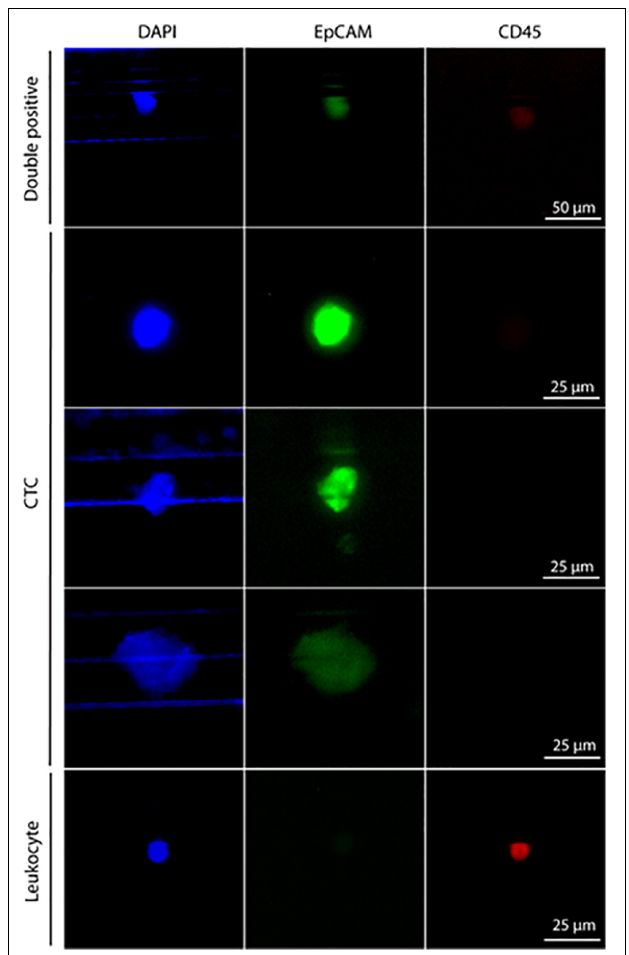
FIGURE 2 | Staining of cells isolated with Parsortix from patient #95. Cells were forced to pass through a 6.5- µ m cassette in the Parsortix system and then stained with different antibodies. Nuclei stained with DAPI (blue), CD45 (red), and EpCAM (green). From top to bottom: double-positive cells (CD45 + , EpCAM + ) of unknown significance, three exemplary CTCs (CD45 - , EpCAM + ), one exemplary leucocyte (CD45 + , EpCAM - ) Scale bar, 50 µ m (double-positive cells) and 25 µ m (CTCs and